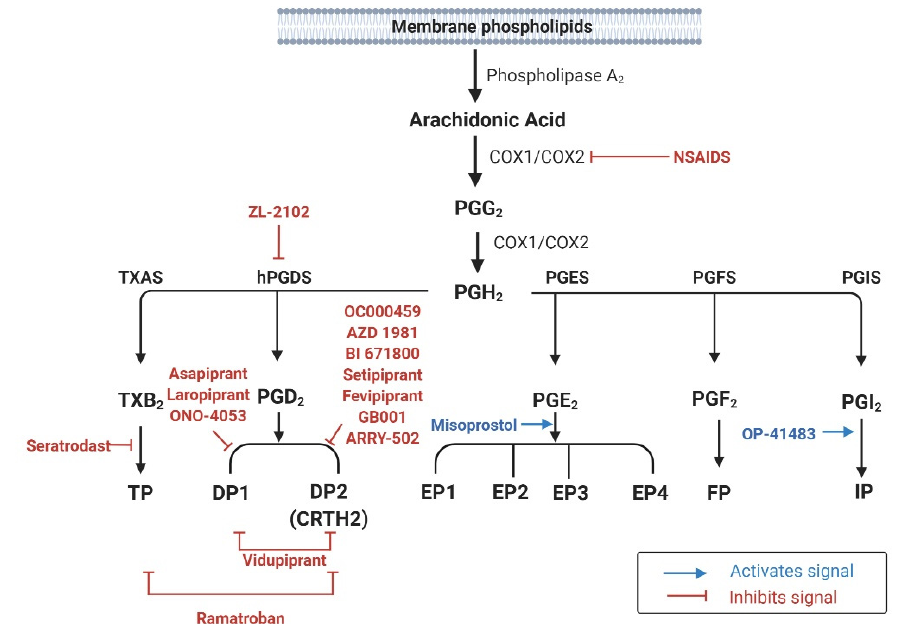
Figure 1. Prostaglandin biosynthesis pathways and pharmacologic agents used in clinical trials for human respiratory allergic